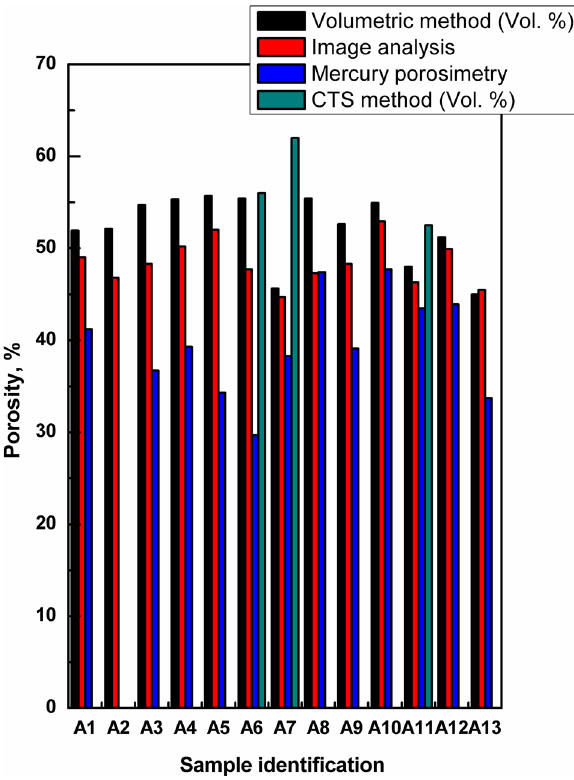
Fig. 9 a Plot of relative pore volume versus pore radius, b variation of cumulative pore volume with pore